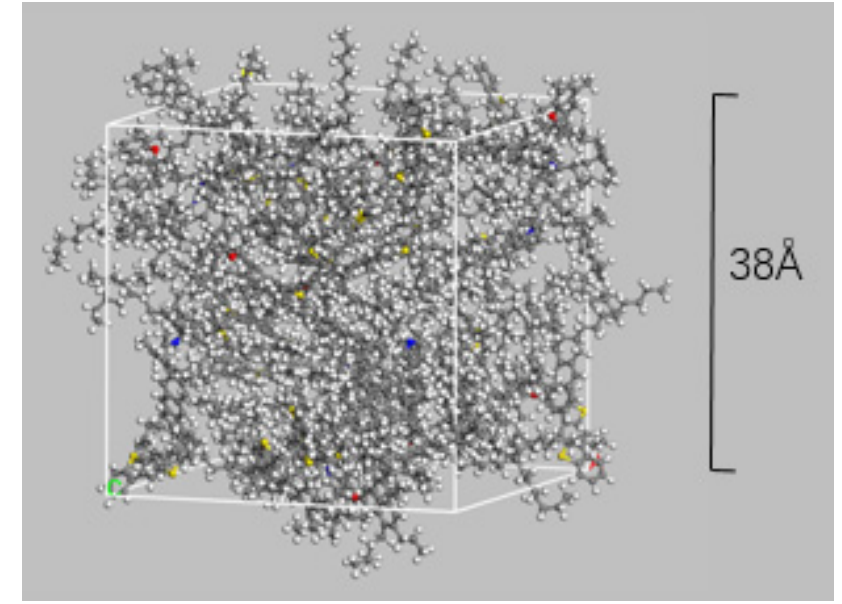
Figure 1. All-atom molecular model of bitumen.